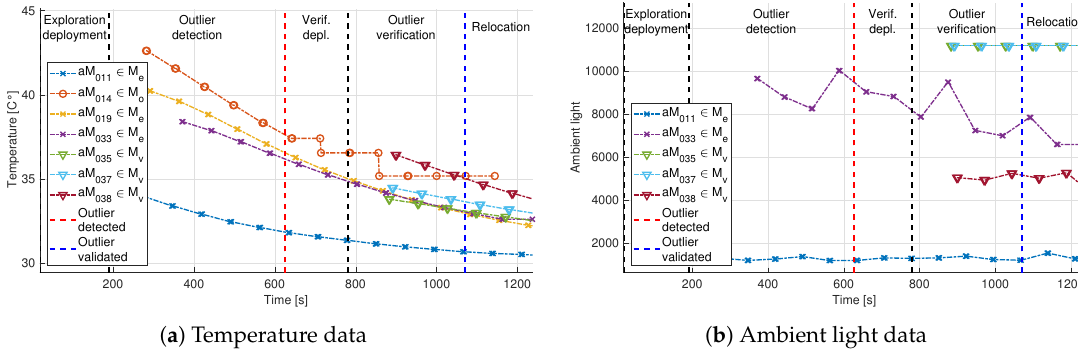
Figure 22. Additional sensor data exchanged via acoustic communication during the Venice